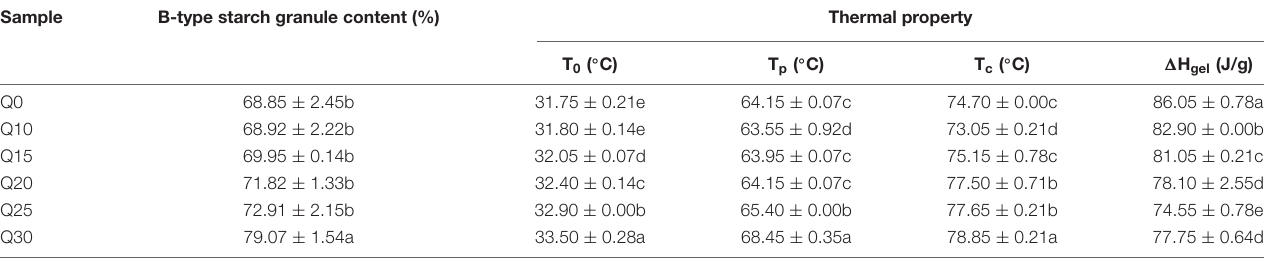
TABLE 2 | B-type starch granule content and thermal properties of starch from the reconstituted flours.